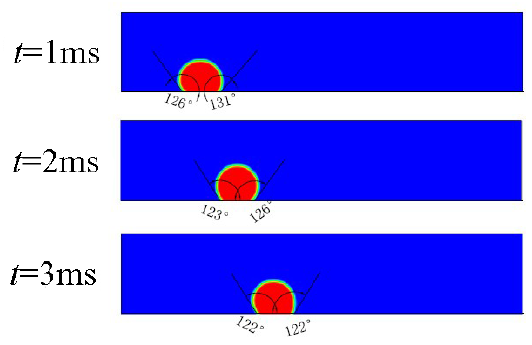
Figure 13. Advancing and receding contact angles during water droplet moving in the flow channel.